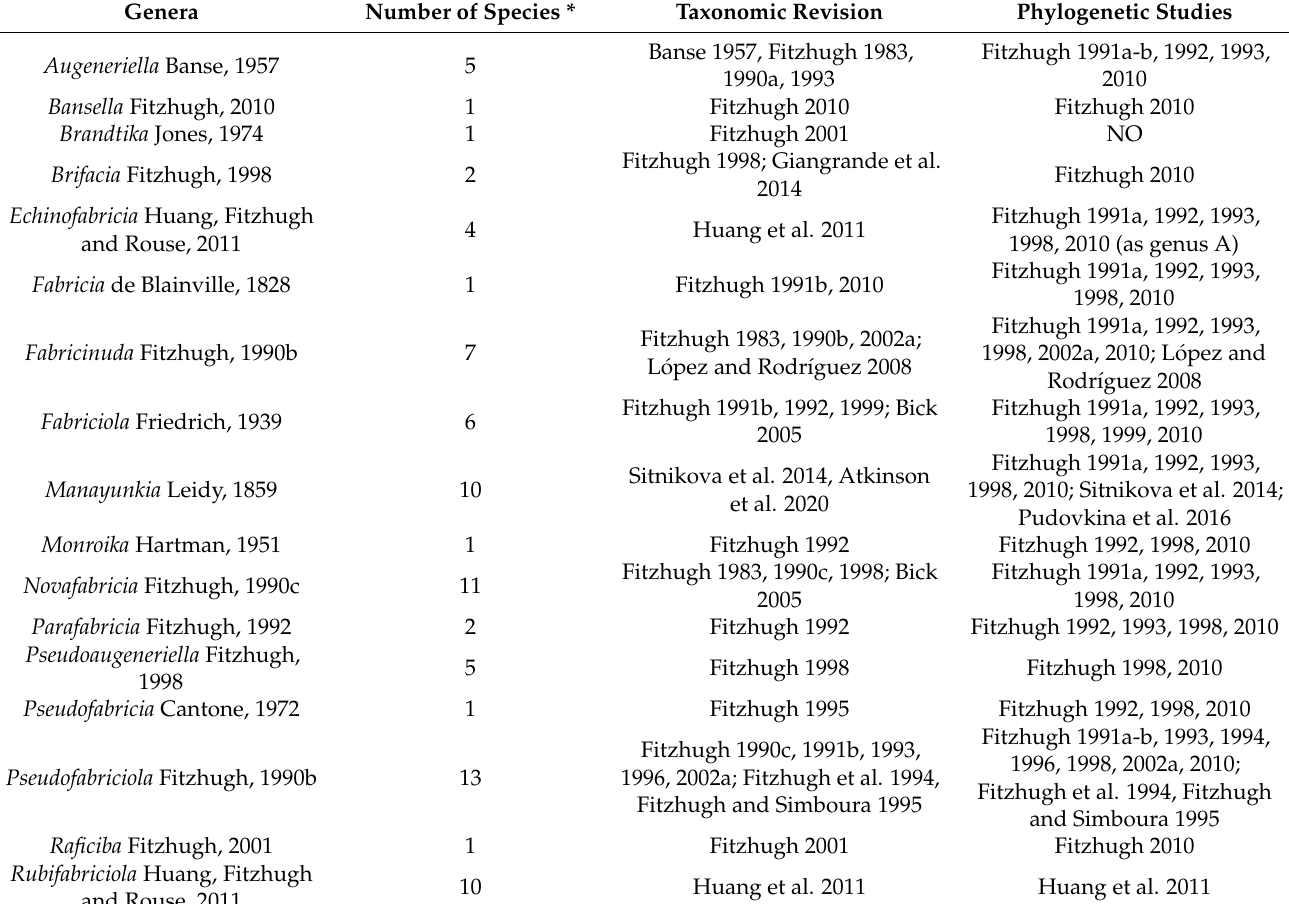
Table 2. Fabriciid currently accepted genera that have undergone major or partial revisions and phylogenetic analyses (based on morphological features, molecular data or